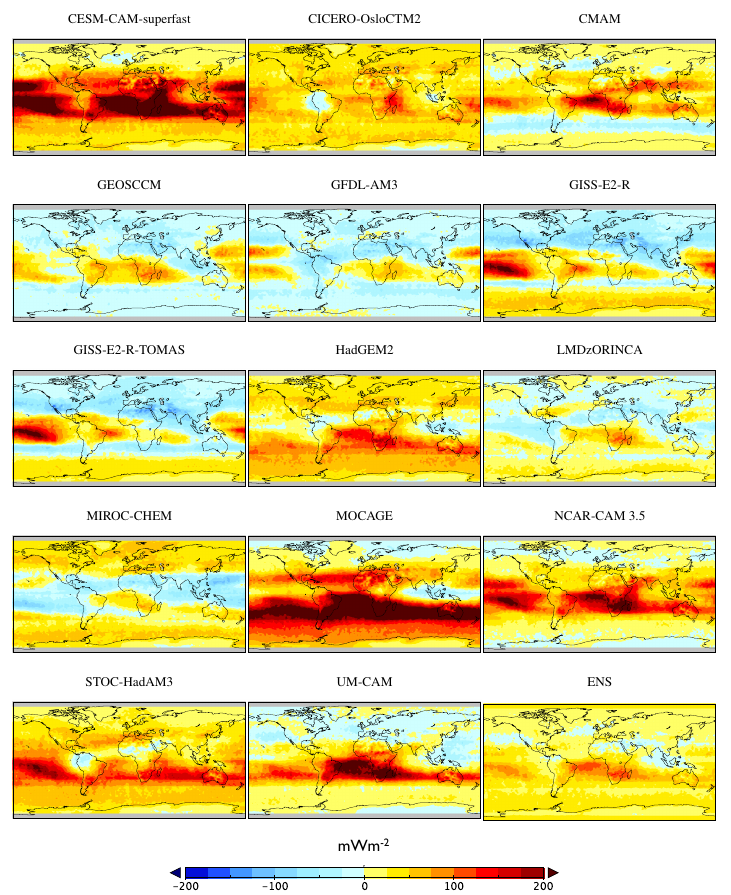
Fig. 4. Spatial distribution of ACCMIP OLR bias from tropospheric ozone, δ OLR j m , from 2005–2010, limited to 80 ◦ S–80 ◦ N, and based on a chemical tropopause q = 150ppb as diagnosed from TES. ACCMIP ensemble, δ OLR j , is denoted by ENS.